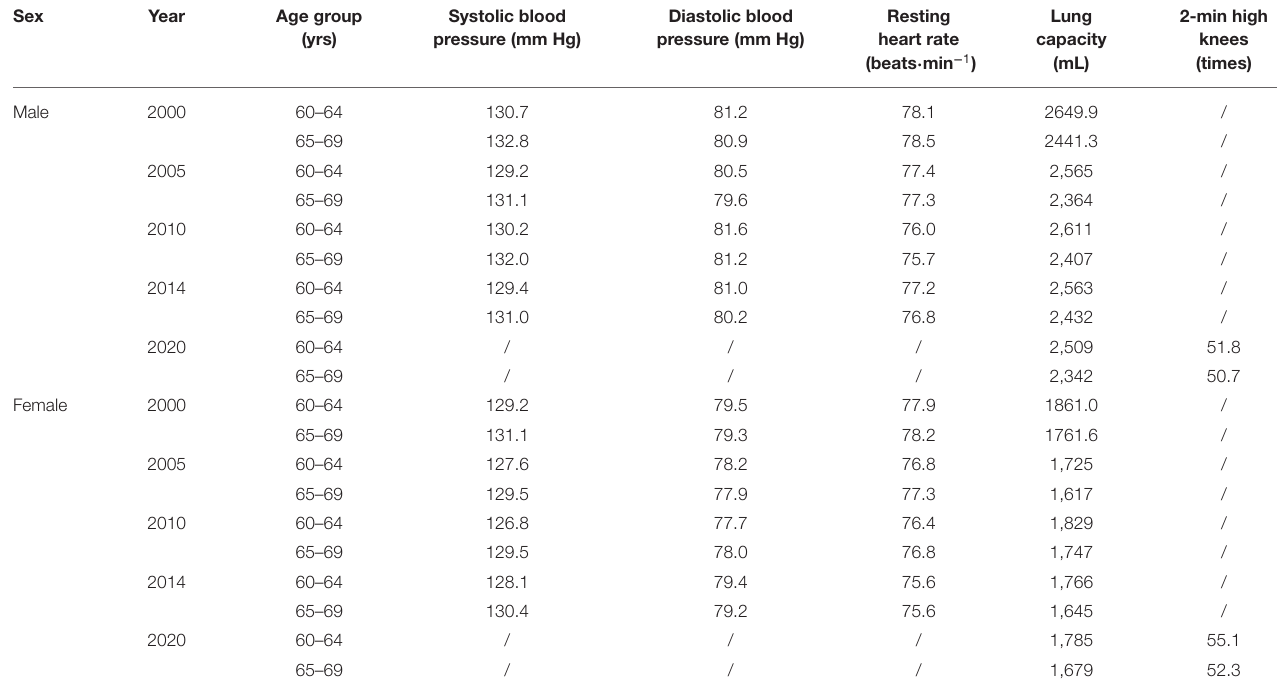
TABLE 3 | Indicators of body function average test results in national physical fitness standards.